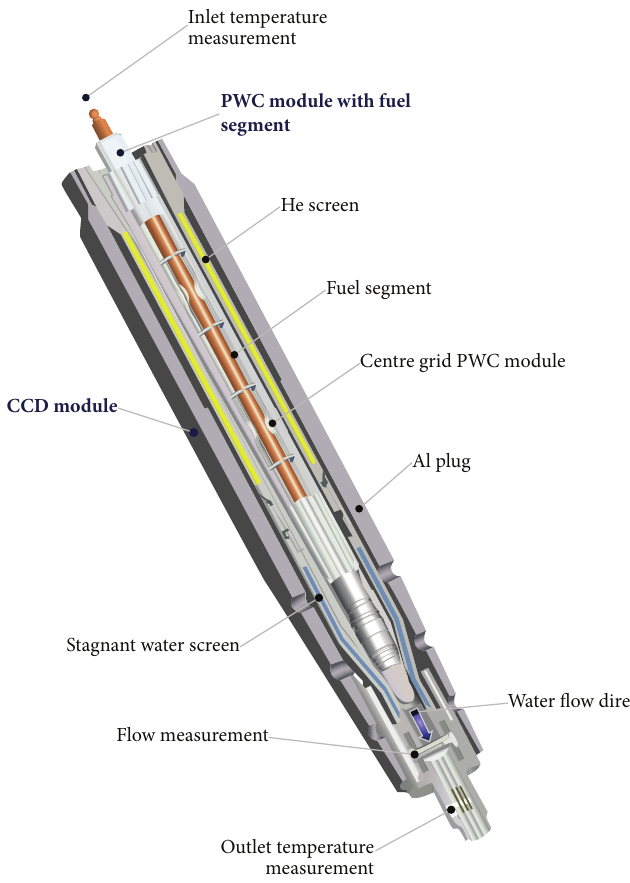
Figure 27: Exploded 3D view of the PWC/CCD assembly